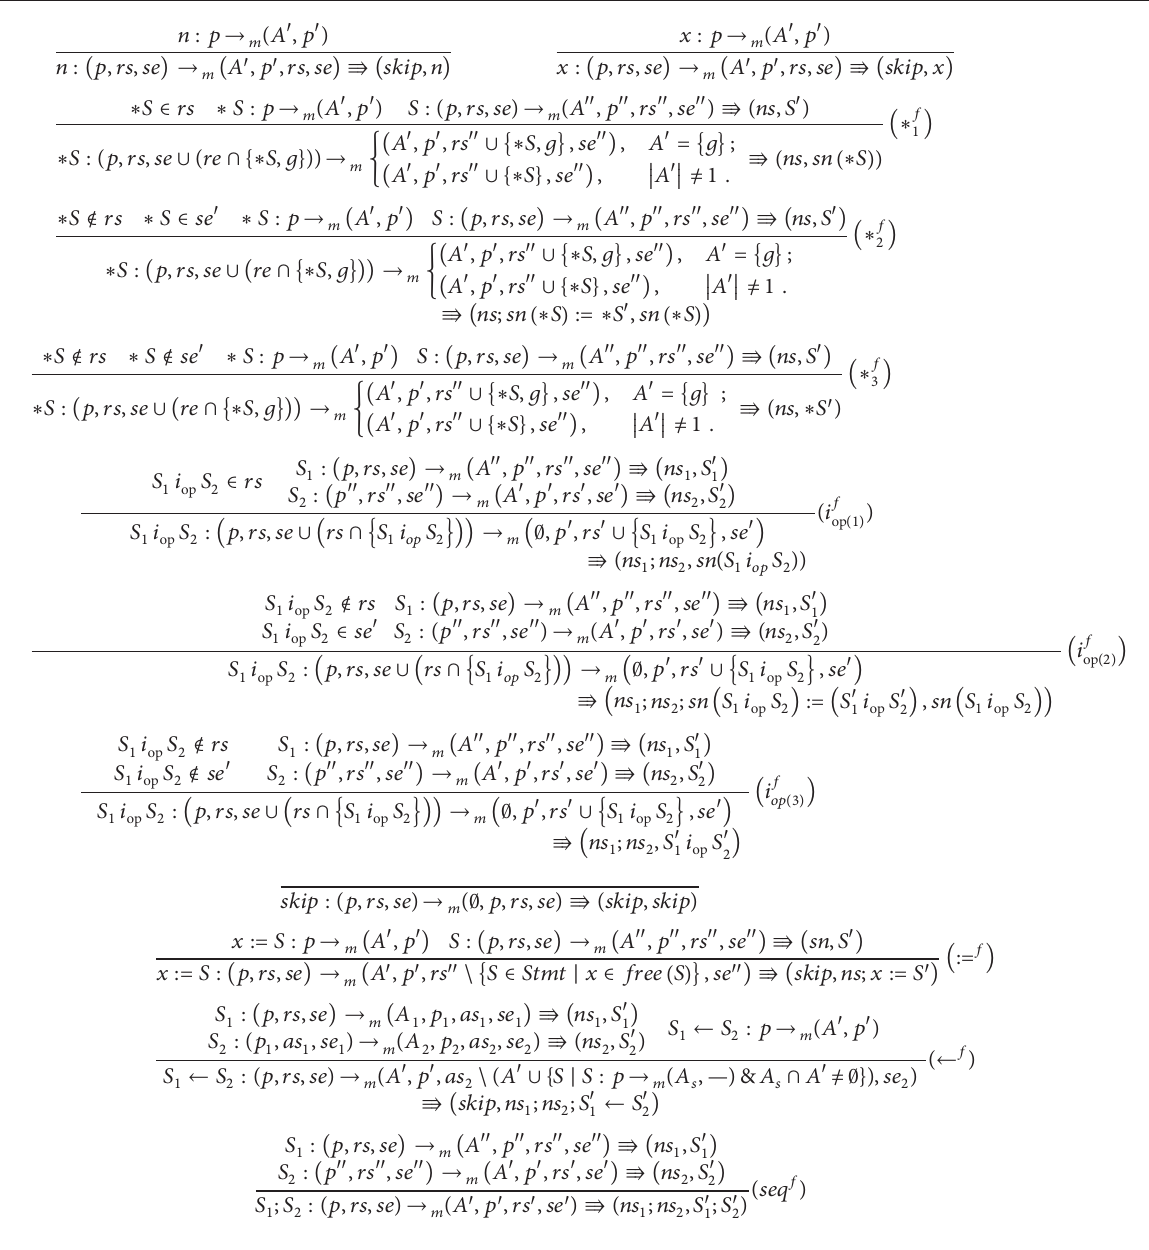
Algorithm 3: Inference rules for the frequent statements and dereferences elimination